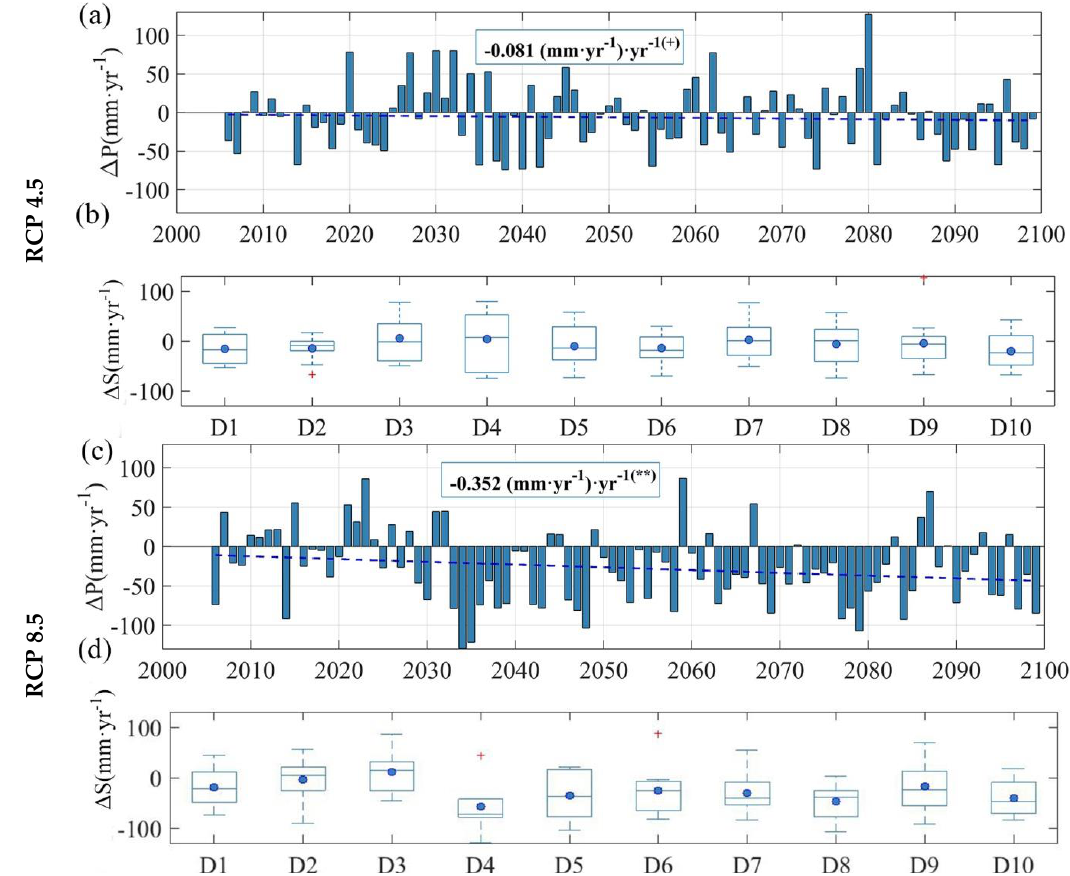
Figure 4. Evolution of the ( a , c ) annual and ( b , d ) decadal mean annual precipitation anomalies for the two global change scenarios analyzed for RCPs 4.5 and 8.5, respectively, during the 2006–2010 period. The trend analysis results are defined according to the Mann-Kendall test as having either (1) excellent significance, 99% (***); (2) good significance, 95% (**); (3) acceptable significance, >90% (*); and (4) no significance, less than 90%